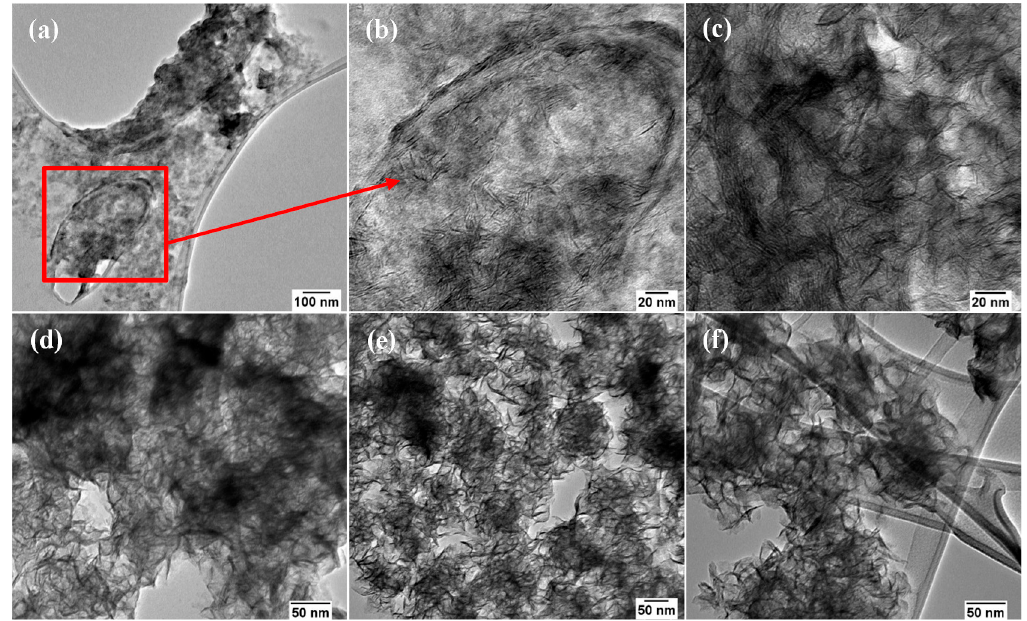
Figure 4. The TEM images of the MoSe 2 nanosheets: ( a , b , c ) are images of the nanomaterial taken at 30 min, ( d , e , f ) are the TEM images for MoSe 2 wrinkled few-layer nanosheets at 60, 90 and 120